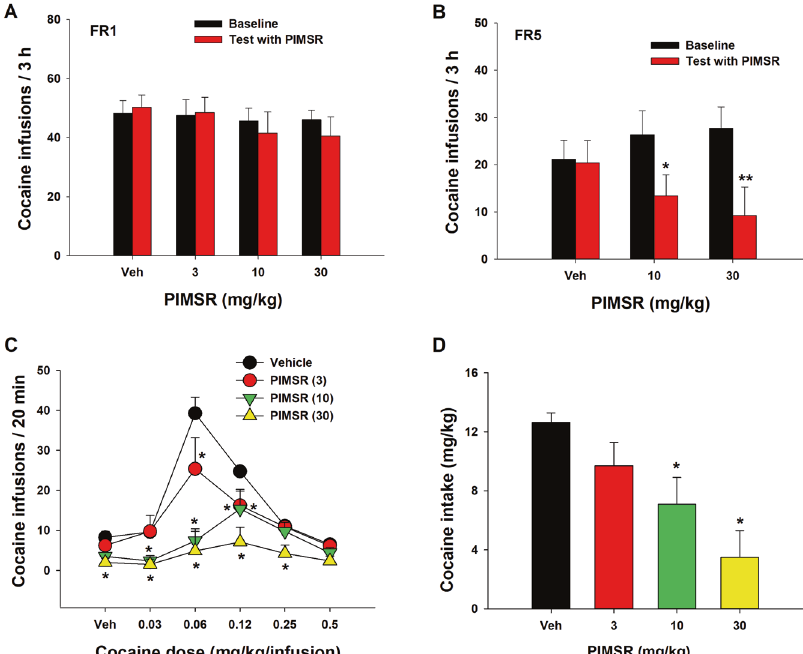
reinforcement in a separate group of rats ( n = 8). C PIMSR signi fi cantly inhibited cocaine self-administration maintained by low-dose cocaine (0.03, 0.06, 0.12, 0.25 mg/kg/infusion) under FR2 reinforcement and shifted the cocaine dose-response curve downward ( n = 8). D PIMSR dose- dependently reduced cocaine intake calculated from the data in C (i.e., sum of cocaine dose × infusions at each cocaine dose). * p < 0.05, ** p < 0.01, com p ared to